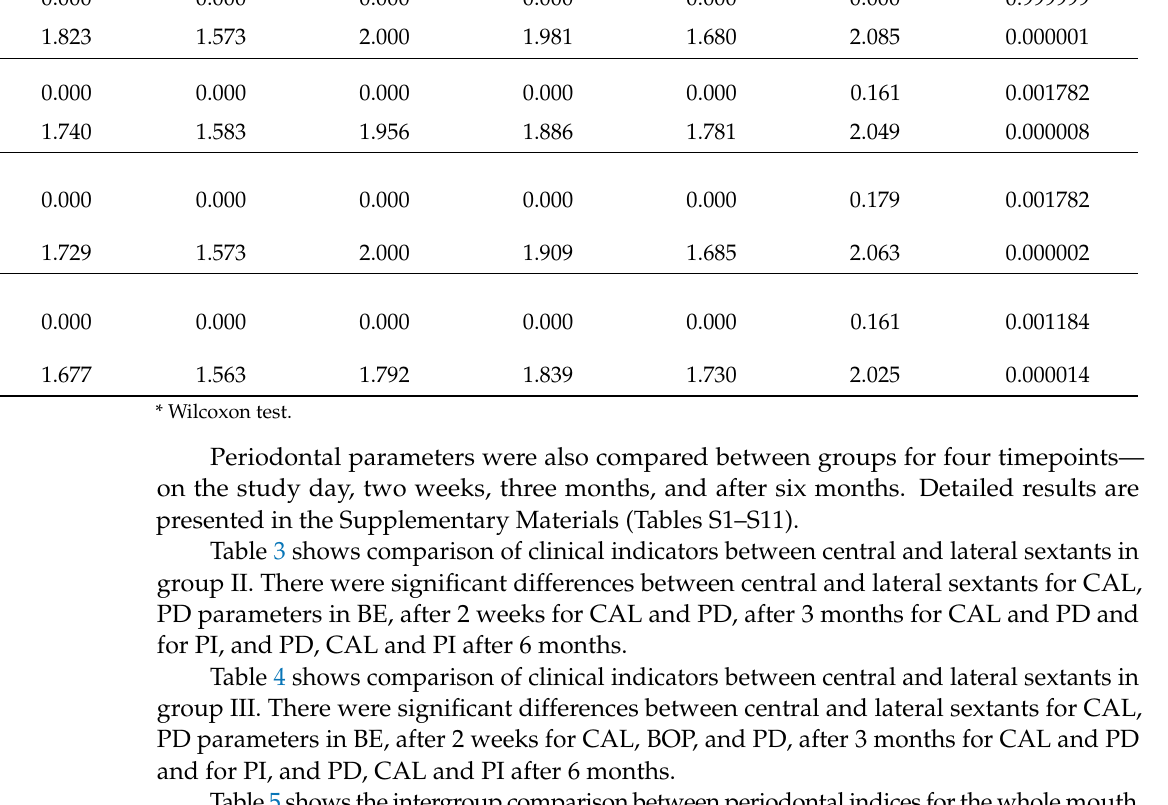
Table 4. Comparison of clinical parameters between central and lateral sextants in the control group. Central Sextants Lateral Sextants Quartile Quartile Median Median